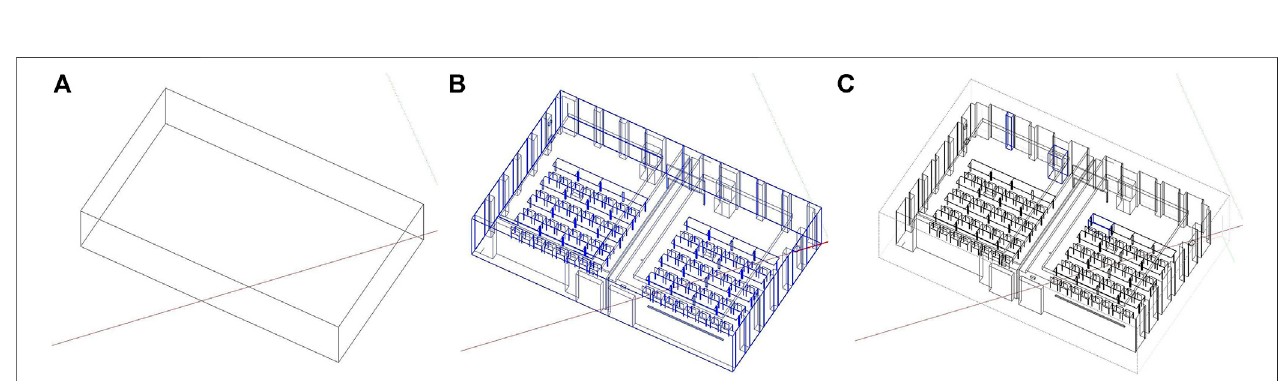
FIGURE 3 | Levels of detail for the geometric de fi nitions of the acoustic cues: (A) effects , from a given volume; (B) cloth mesh as one single net; (C) objec t meshes, as independent geometries.